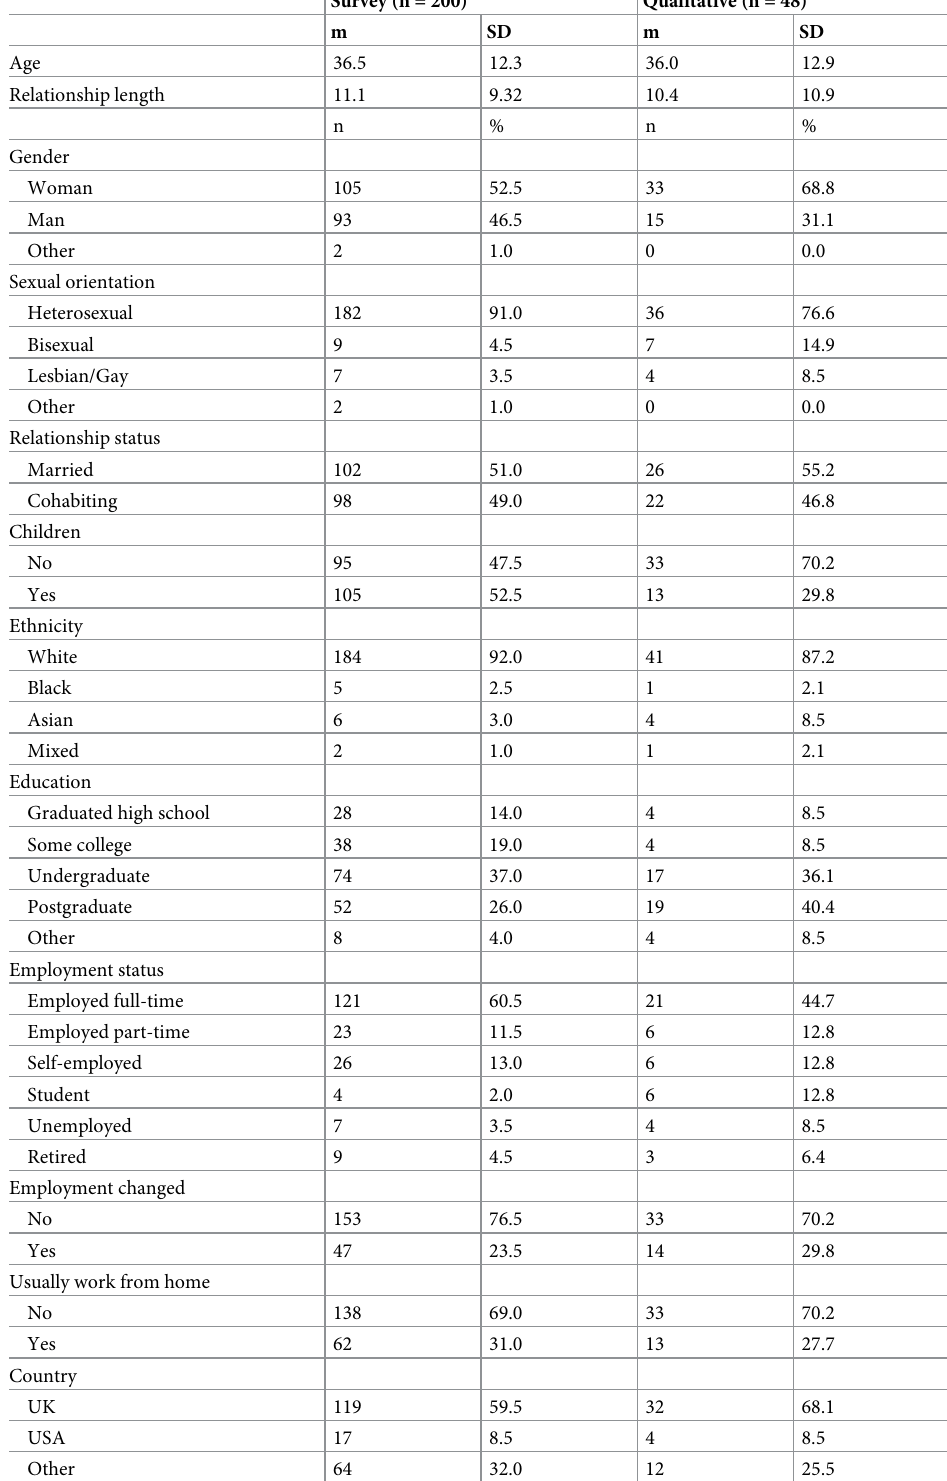
Table 1. Demographic